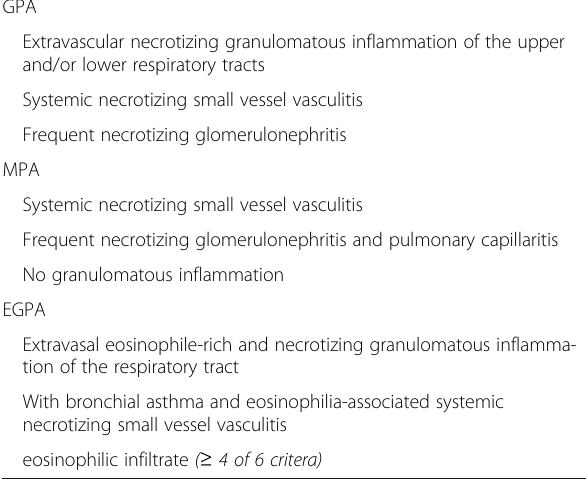
Table 3 Chapel Hill Consensus Conference (CHCC) Nomenclature for Granulomatosis with Polyangiitis (GPA), Microscopic Polyangiitis (MPA) and Eosinophilic Granulomatosis with Polyangiitis (EGPA) GPA Extravascular necrotizing granulomatous inflammation of the upper and/or lower respiratory tracts Systemic necrotizing small vessel vasculitis Frequent necrotizing